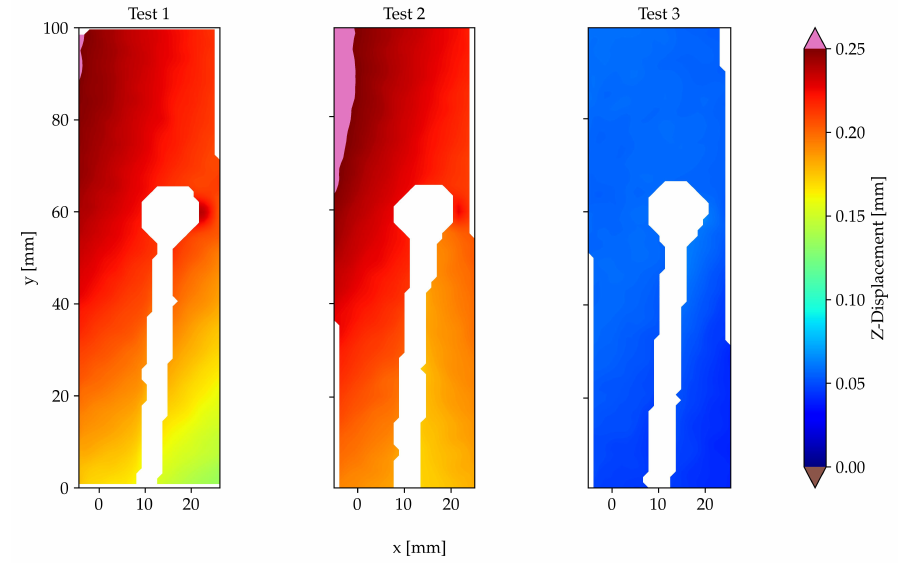
Figure 18. Out-of-plane motion, as captured by stereo-DIC, for the 700th image taken in the